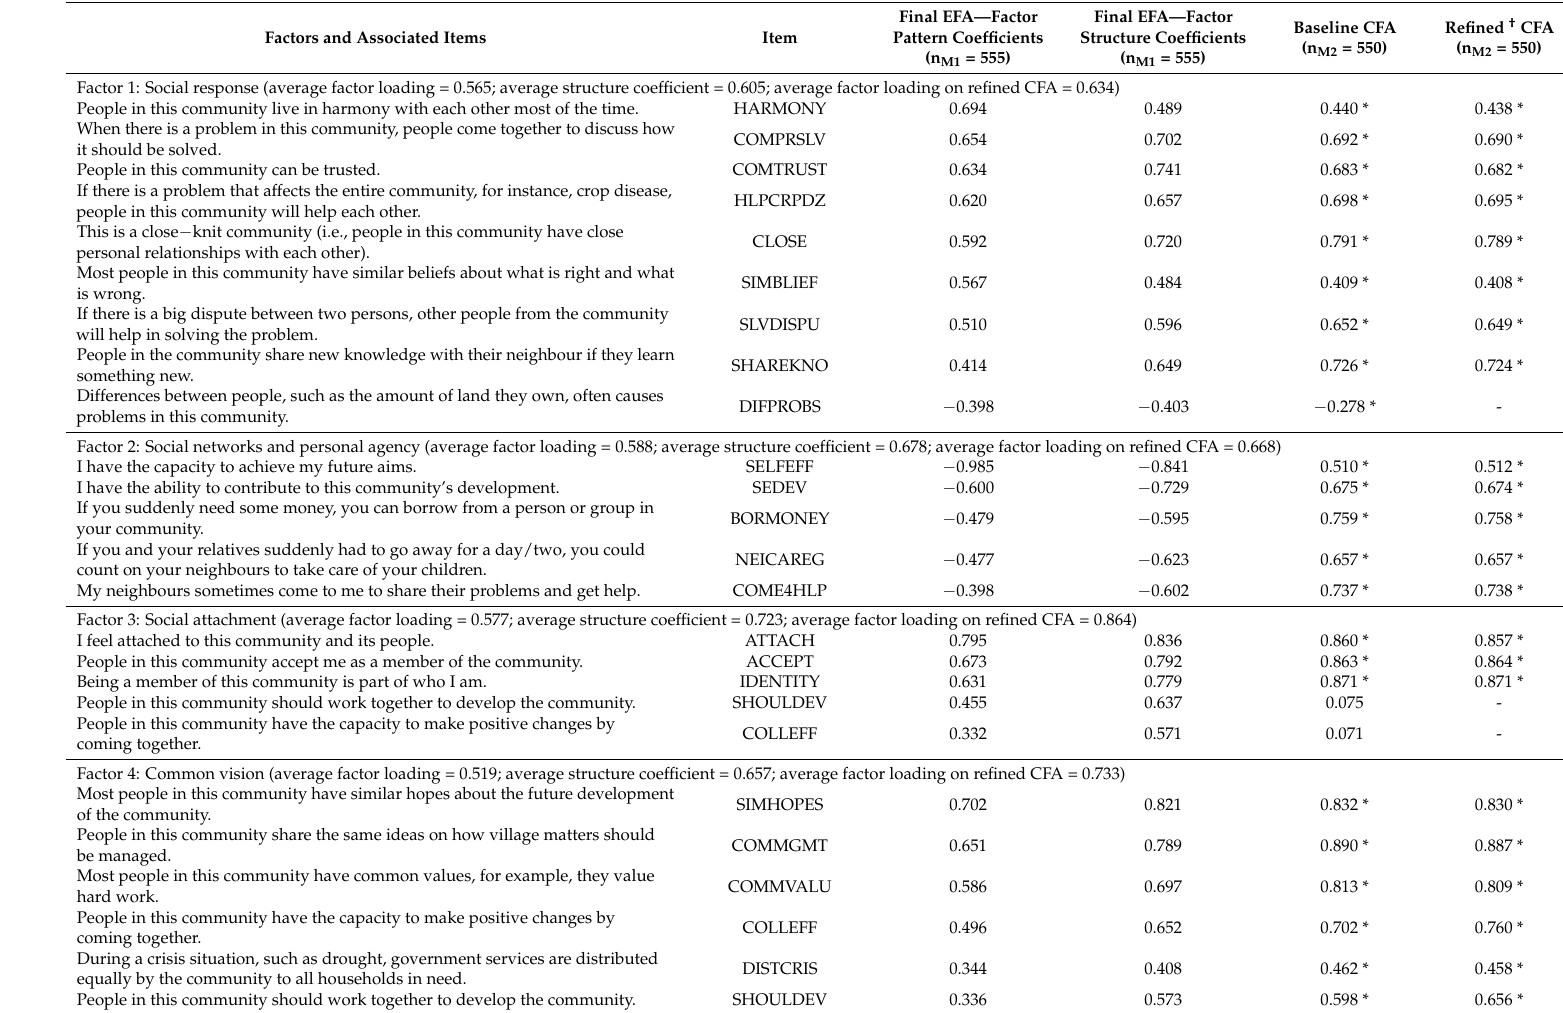
Table 3. Factor loadings for random split-half samples for EFA and CFA of EFA-derived factor solutions,